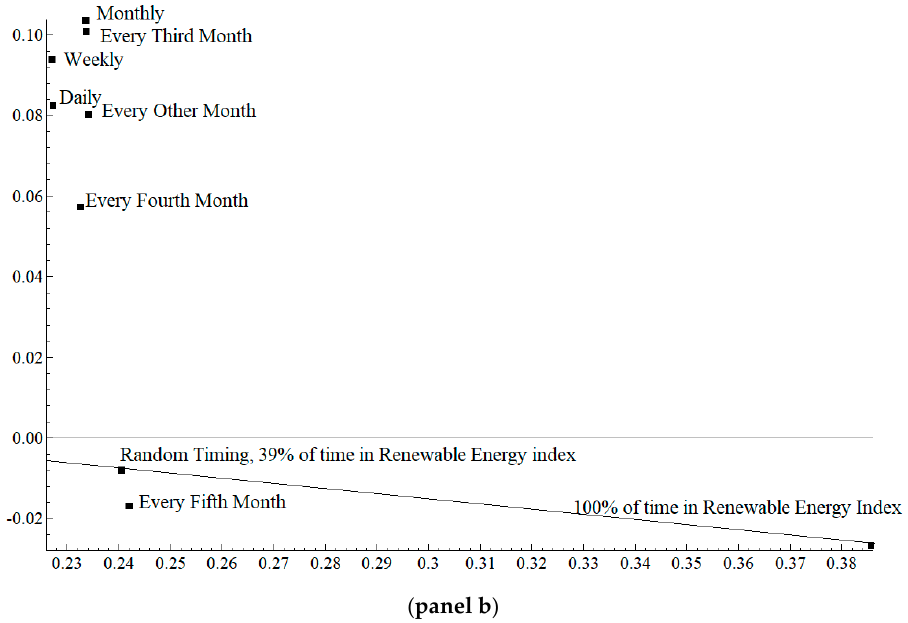
Figure 10. Returns to volatility ratios in Stoxx 600 Europe Renewable Energy Index, 2 December 2008 to 28 September 2018, compared with random timing. ( panel a ) Calculated daily, weekly, monthly, every second month, every third month, every fourth month, and every fifth month; ( panel b ) Calculated with maximal rolling window, daily (MA200), weekly (MAW40), monthly (MA10), every second month (MAD5), every third month (MAT4), every fourth month (MAQ3), and every fifth month (MAC2).